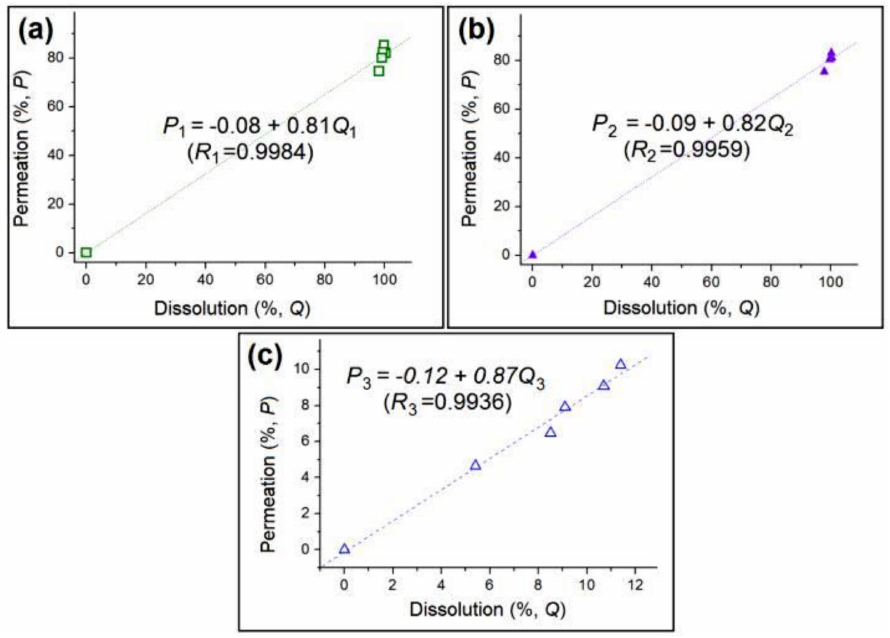
Figure 11. Relationship between the in vitro dissolution and ex vivo permeation data of N1 ( a ), N2 ( b ), and the raw KET powders ( c